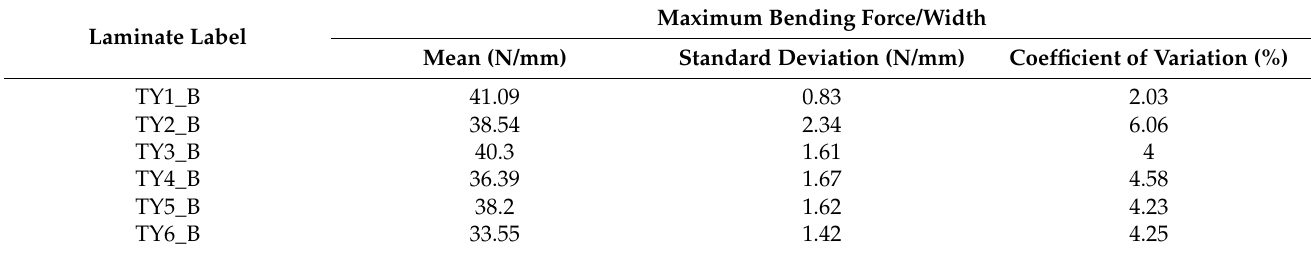
Table 4. Maximum bending force per unit width for different batches of specimens.